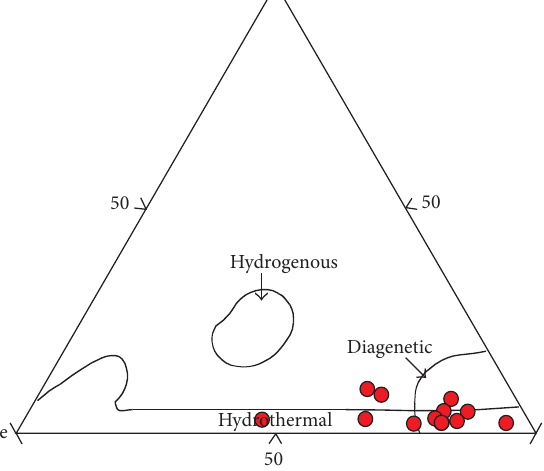
× 10-Mn discrimination diagram [9, 10,